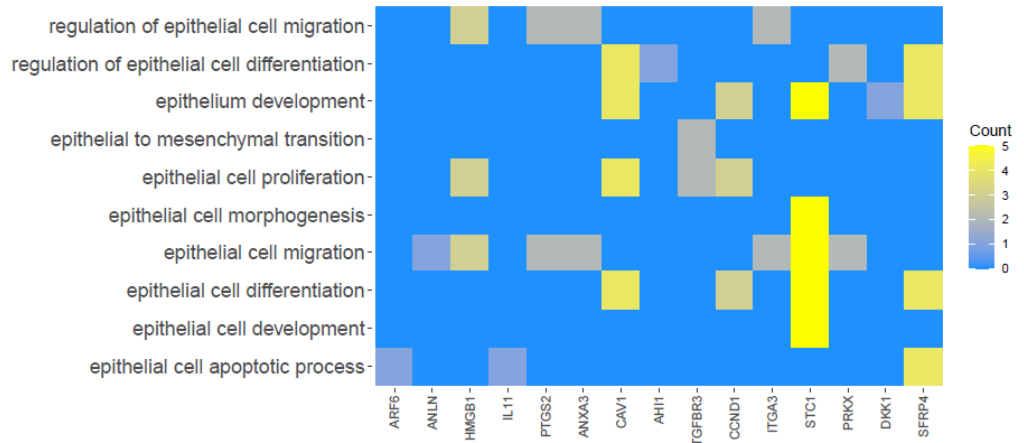
Figure 3. Heatmap illustrating 15 genes based upon the selected GO BP terms. The yellow color is associated with genes relative to the GO Term. The intensity of the color corresponds to the amount of GO BP terms.